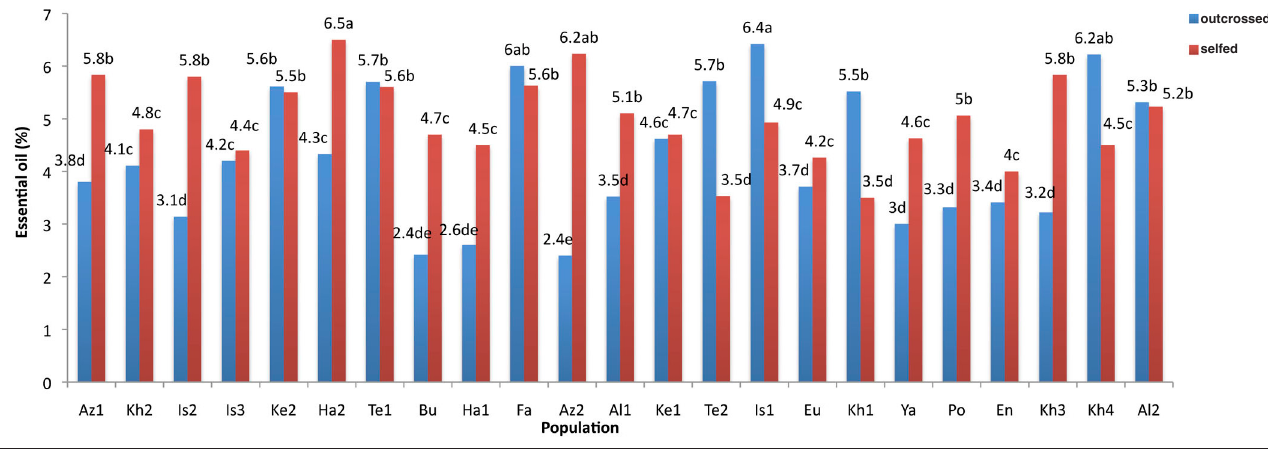
Fig. 2: Essential oil yield in outcross and self-pollinated populations of fennel used in this study.